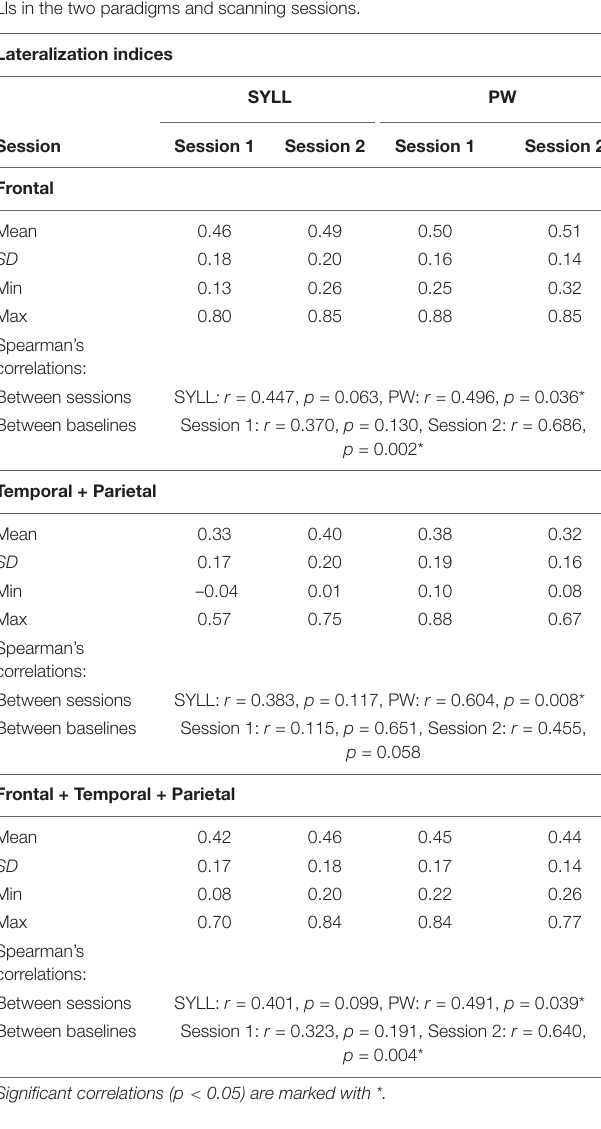
TABLE 2 | Lateralization indices for each paradigm (SYLL: syllable baseline vs. PW: pseudoword baseline) in three regions (frontal, temporal-parietal, frontal-temporal-parietal) along with results of Spearman’s correlations between LIs in the two paradigms and scanning